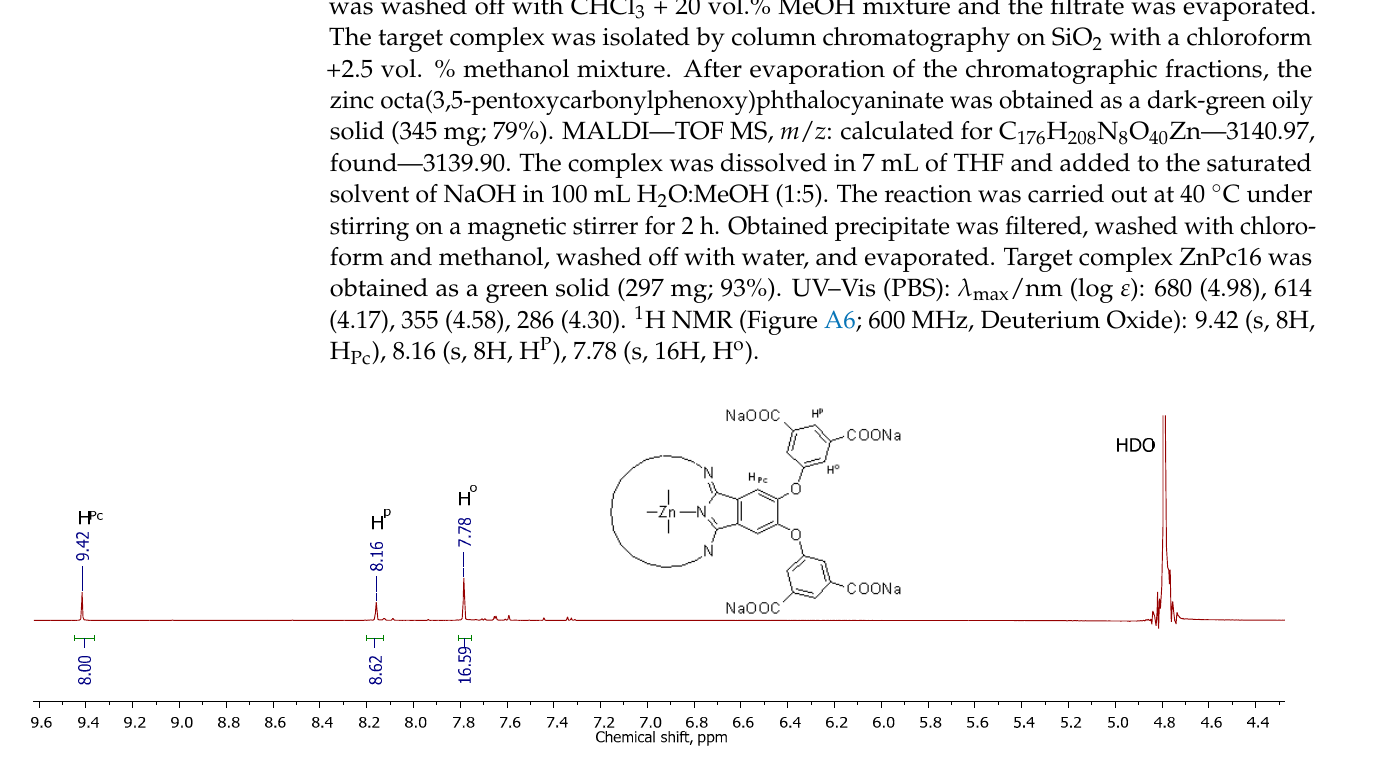
Figure A6. 1 H NMR spectrum of the solution of ZnPc16 in D 2 O.